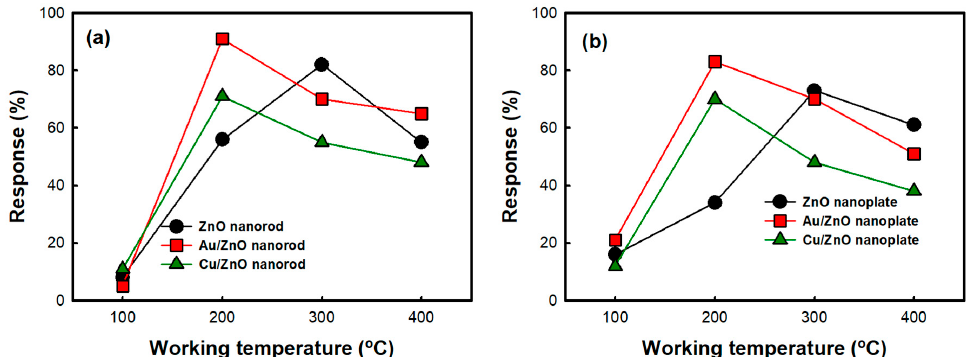
Figure 4. The gas response of the samples up to 100 ppm CO as a function of working temperature ( a ) ZnO nanorod and metal-deposited ZnO nanorods ( b ) ZnO nanoplate and metal-deposited ZnO nanoplates. Table 3. The gas response, response time, and recovery time of the samples. Sample